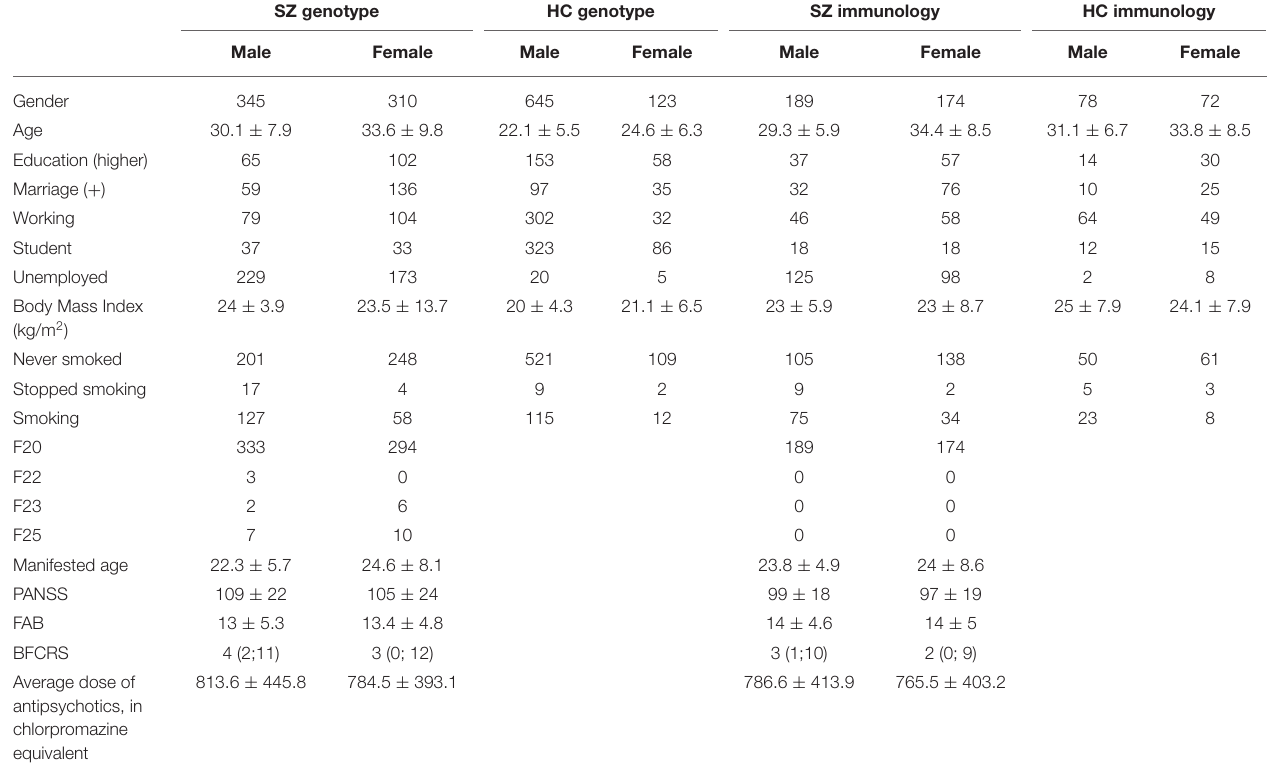
TABLE 1 | Baseline characteristics of patients and healthy